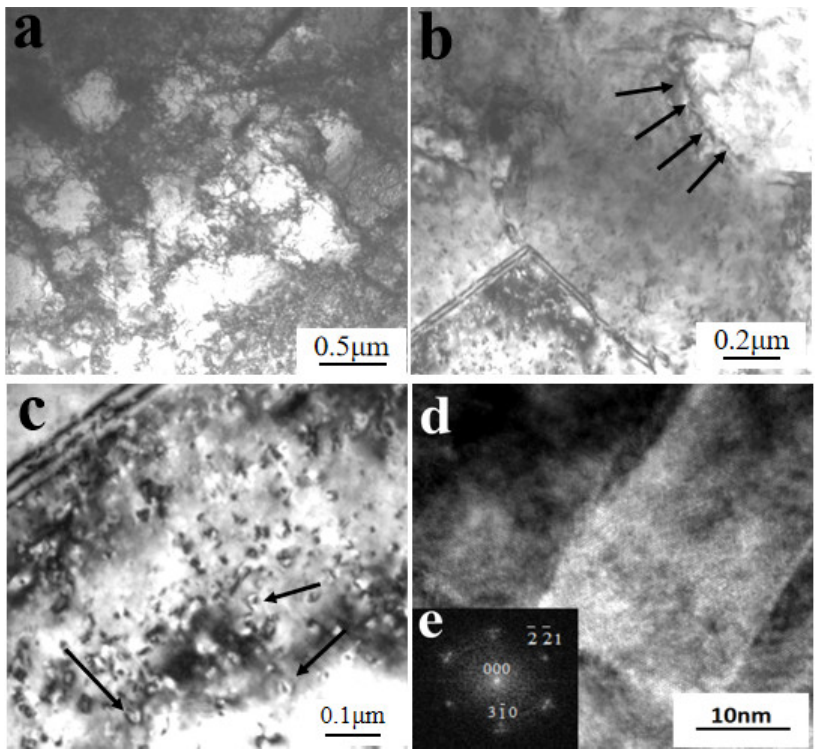
Figure 8. TEM microstructure of the matrix of W f /Cu 82 Al 10 Fe 4 Ni 4 composites: ( a ) dislocation cells, ( b ) sub-grain-boundary, ( c ) precipitates and dislocation loops, ( d ) HREM morphology of Al 3 Ni, and ( e ) SADP of Al 3 Ni.